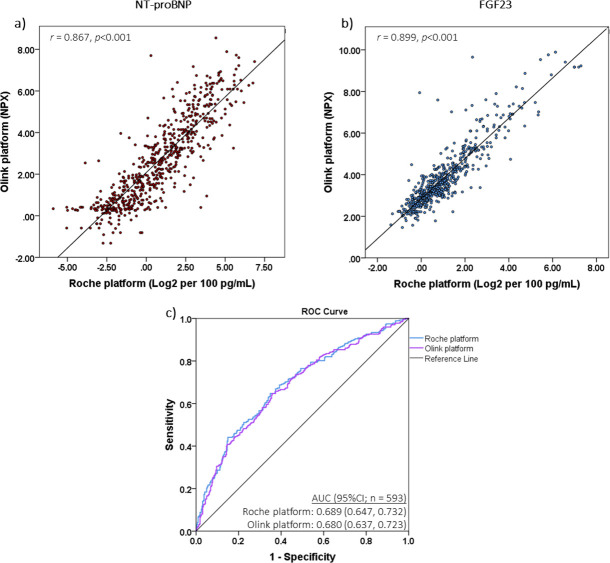
Comparison between assays.Values of (a) NT-proBNP and (b) FGF23 measured on the Roche platform highly correlated with those measured on the Olink platform. (c) Model performance calculated using biomarkers quantified on both platforms was identical. AUC, area under the receiver operating characteristic curve; NPX, Normalized Protein eXpression; ROC, receiver operating characteristic.